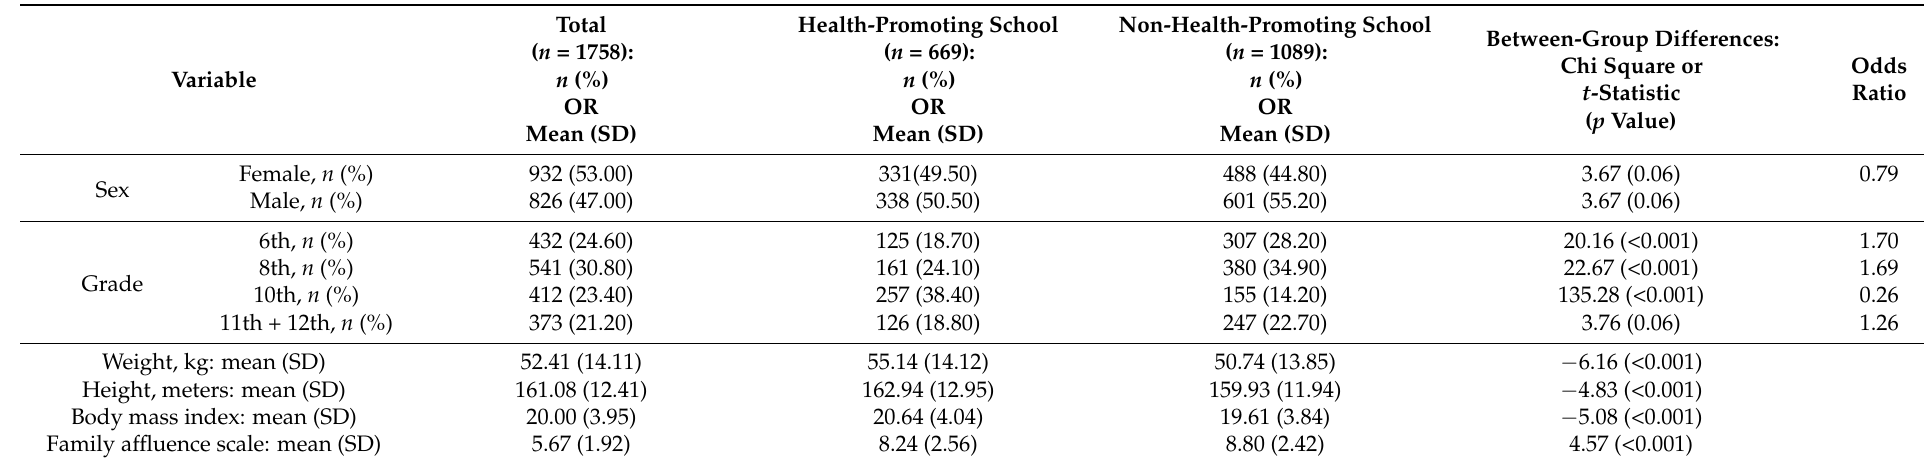
Table 1. Characteristics of schools and study